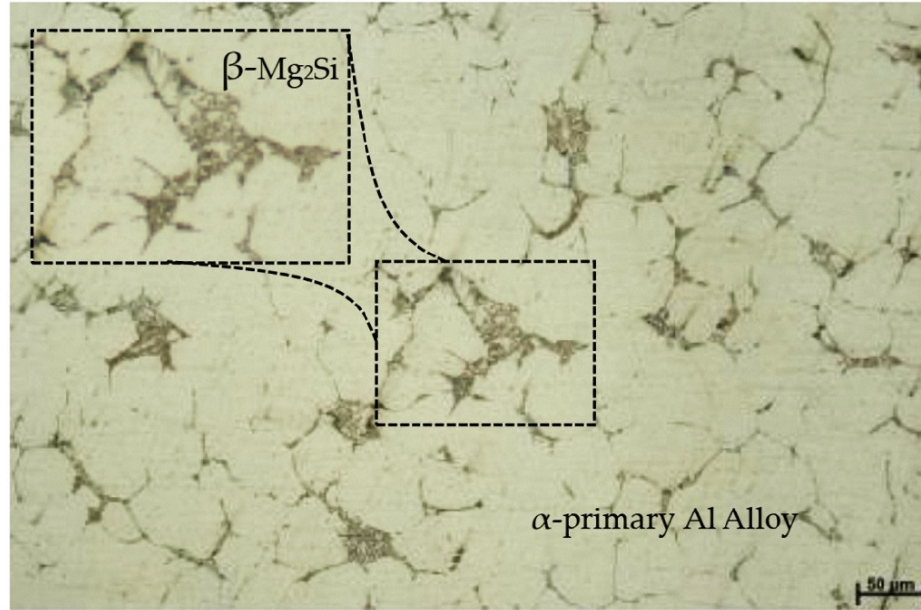
Figure 1. The photography of base globular microstructure on SSM6061 aluminum alloys.